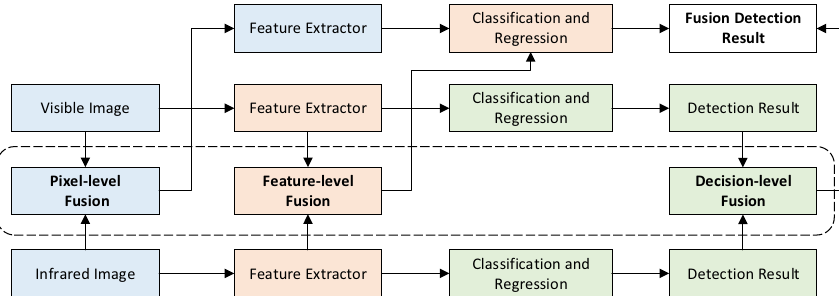
Fig. 1 Three ways to fuse visible and infrared images